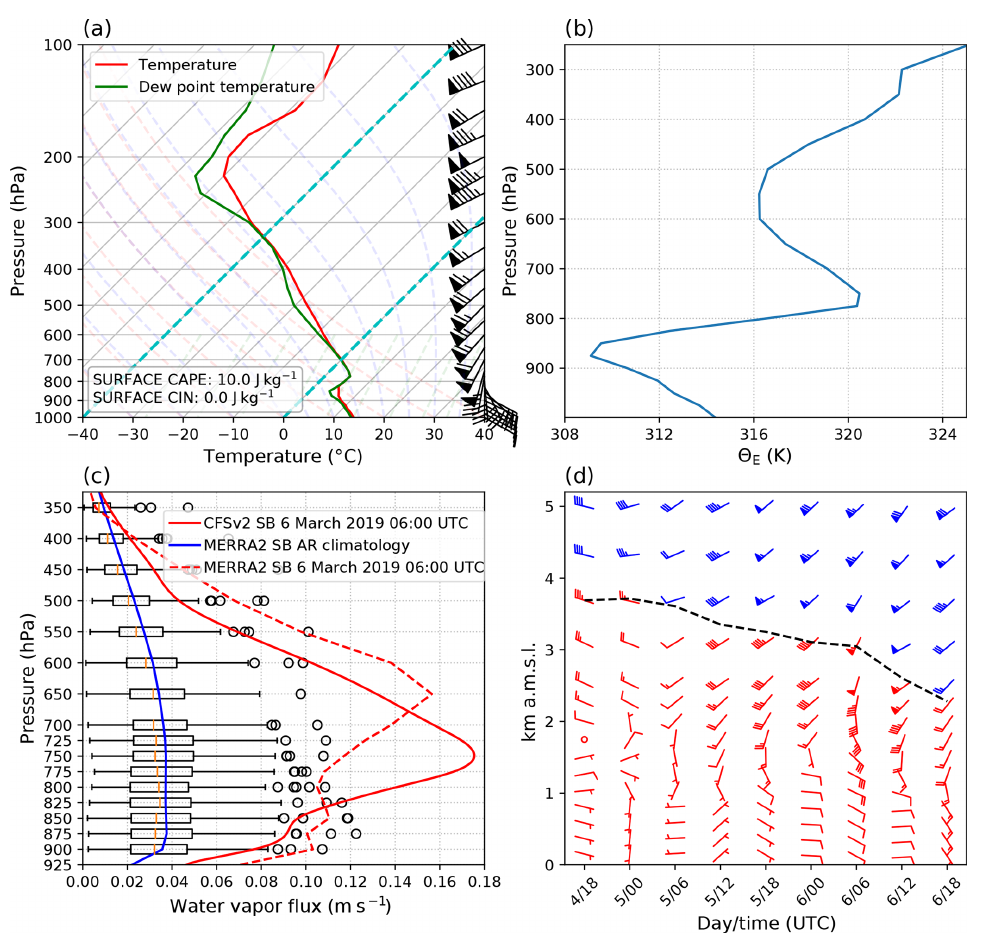
Figure 3. (a) Skew(t)–log(p) vertical profile of CFSv2 temperature (red line) and dew point (green line) at 34.5 ◦ N and 119.5 ◦ W on 6 March 2019 06:00UTC. CFSv2 winds (knots; barbs) are indicated on the right side of the figure for each vertical level. Surface val- ues of CAPE and convective inhibition (CIN) are shown in the bottom left corner. (b) CFSv2 equivalent potential temperature θ E (blue line; K) at 34.5 ◦ N and 119.5 ◦ W on 6 March 2019 06:00UTC. (c) Climatological vertical profile of horizontal water vapor flux (ms − 1 ) based on MERRA-2 at 34.5 ◦ N, 119.375 ◦ W for all days when AR conditions are met during the month of March between 1980 and 2015 (i.e., IVT > = 250kgm − 1 s − 1 ) at this location (blue line and box-and-whisker plots show the distribution of the 170 events), and vertical profile of horizontal water vapor flux (ms − 1 ) based on CFSv2 (red solid line) and MERRA-2 (red dashed line) at the same location on 6 March 2019 06:00UTC. (d) CFSv2 winds (knots, barbs) at vertical levels (kilometers above mean sea level) at 34.5 ◦ N and 119.5 ◦ W at 6h intervals from 4 March 2019 18:00UTC to 6 March 2019 18:00UTC. The temperature ( ◦ C) is indicated by the color of the barb. Red barbs mean the temperature was greater than 0 ◦ C, and blue barbs mean the temperature was less than 0 ◦ C. The height of the 0 ◦ C isotherm is indicated by the black dashed